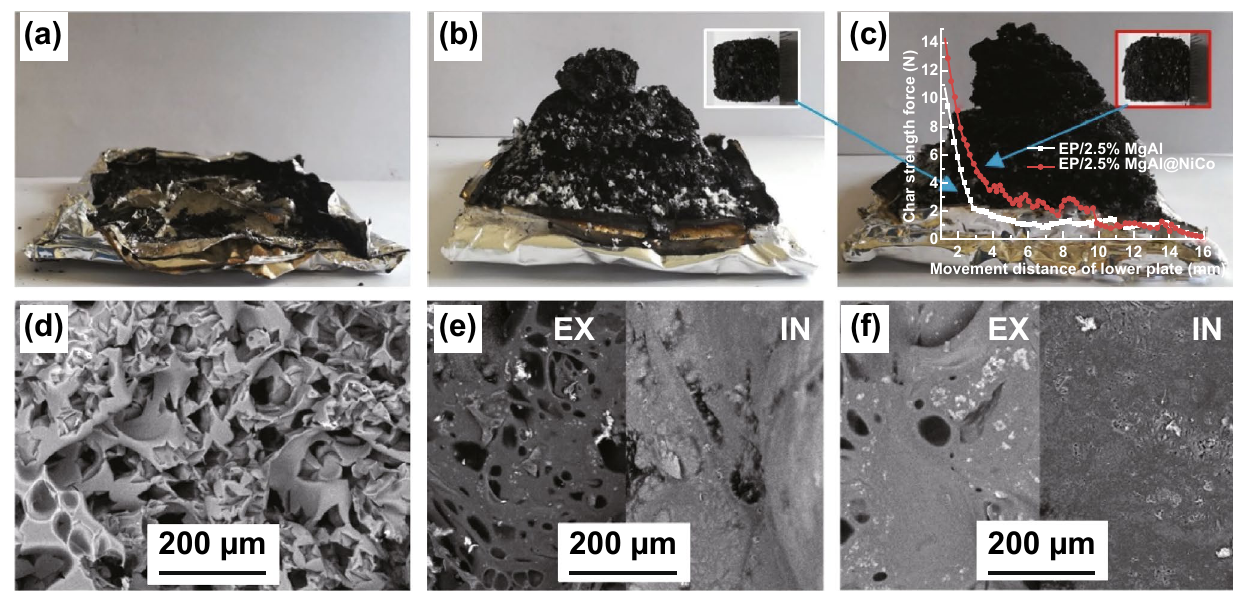
Fig. 6 a – c Front view and d – f SEM images of char after the cone calorimeter test for EP, EP/2.5% MgAl, EP/2.5% MgAl@NiCo, respectively. Adapted from Ref. [51] with permission from